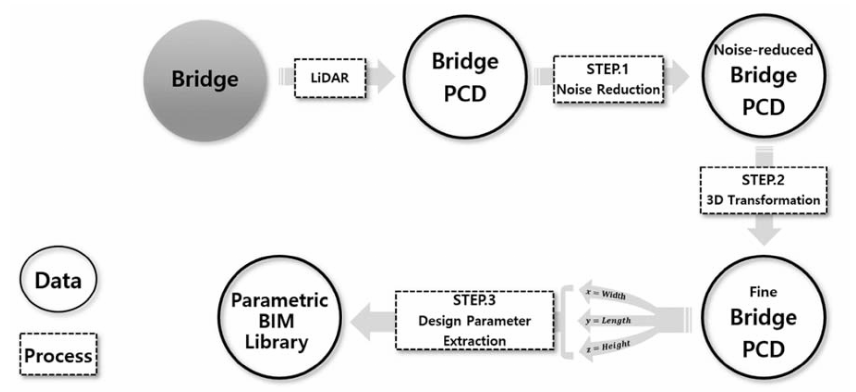
Figure 1. Overview of the automated design parameter extraction for bridges.